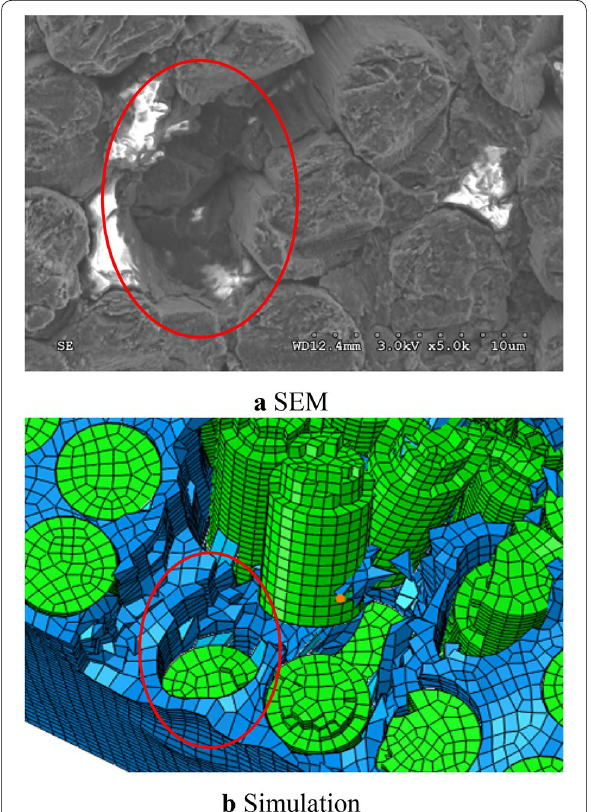
Figure 6 Hole defects due to the fracture of local single carbon fiber